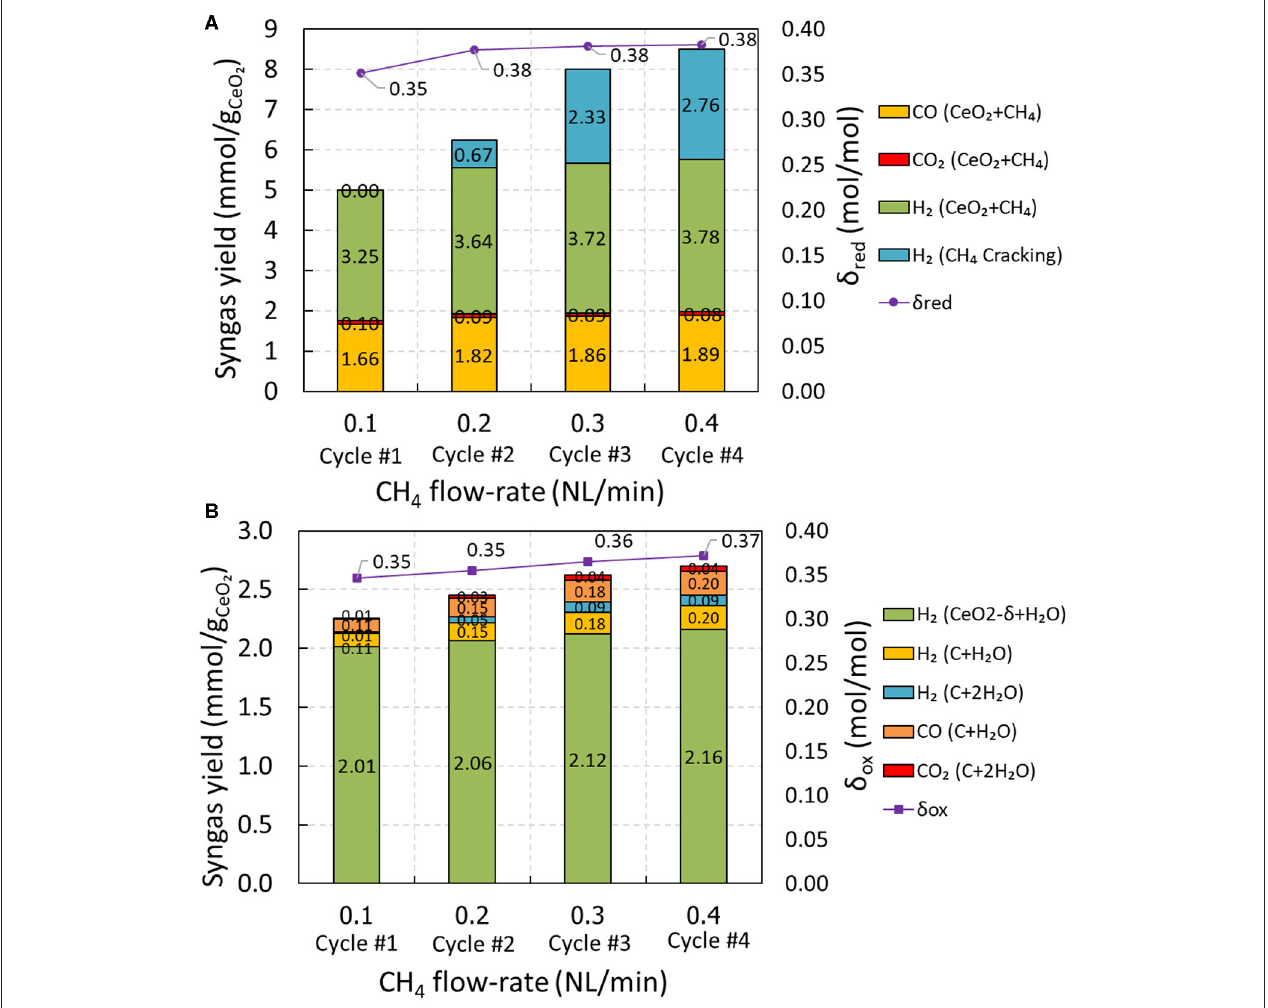
FIGURE 9 | Syngas yield and δ for (A) reduction and (B) oxidation of ceria foam cycled isothermally at 1,000 ◦ C as a function of inlet CH 4 flow rate.